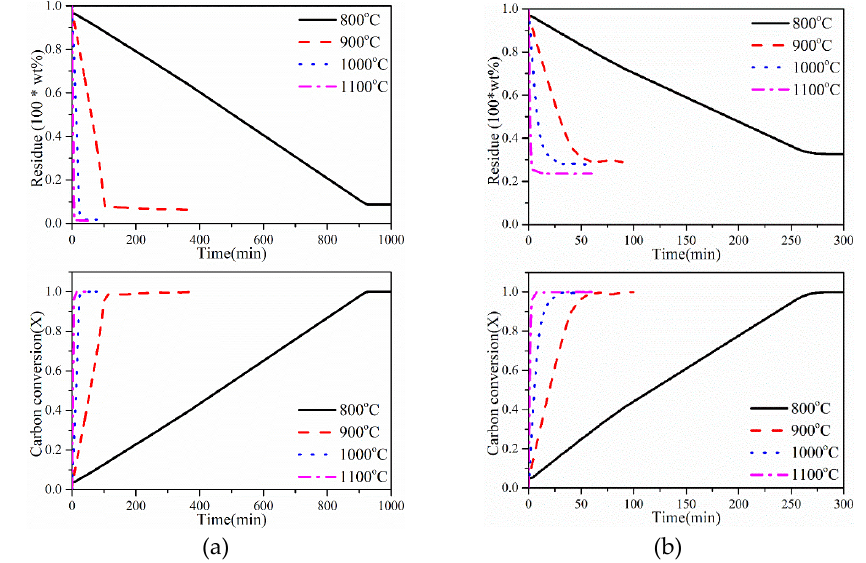
Figure 1. Effects of temperatures on gasification performance of RAW and AW coals with thermo gravimetric and carbon conversion. ( a ) AW, ( b ) RAW.